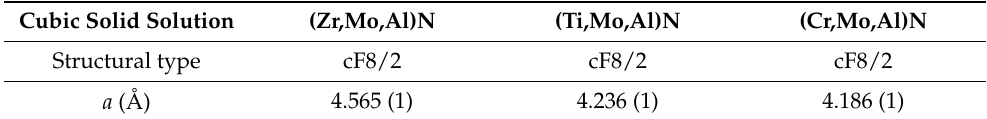
Table 1. Phase composition with lattice parameters. Cubic Solid